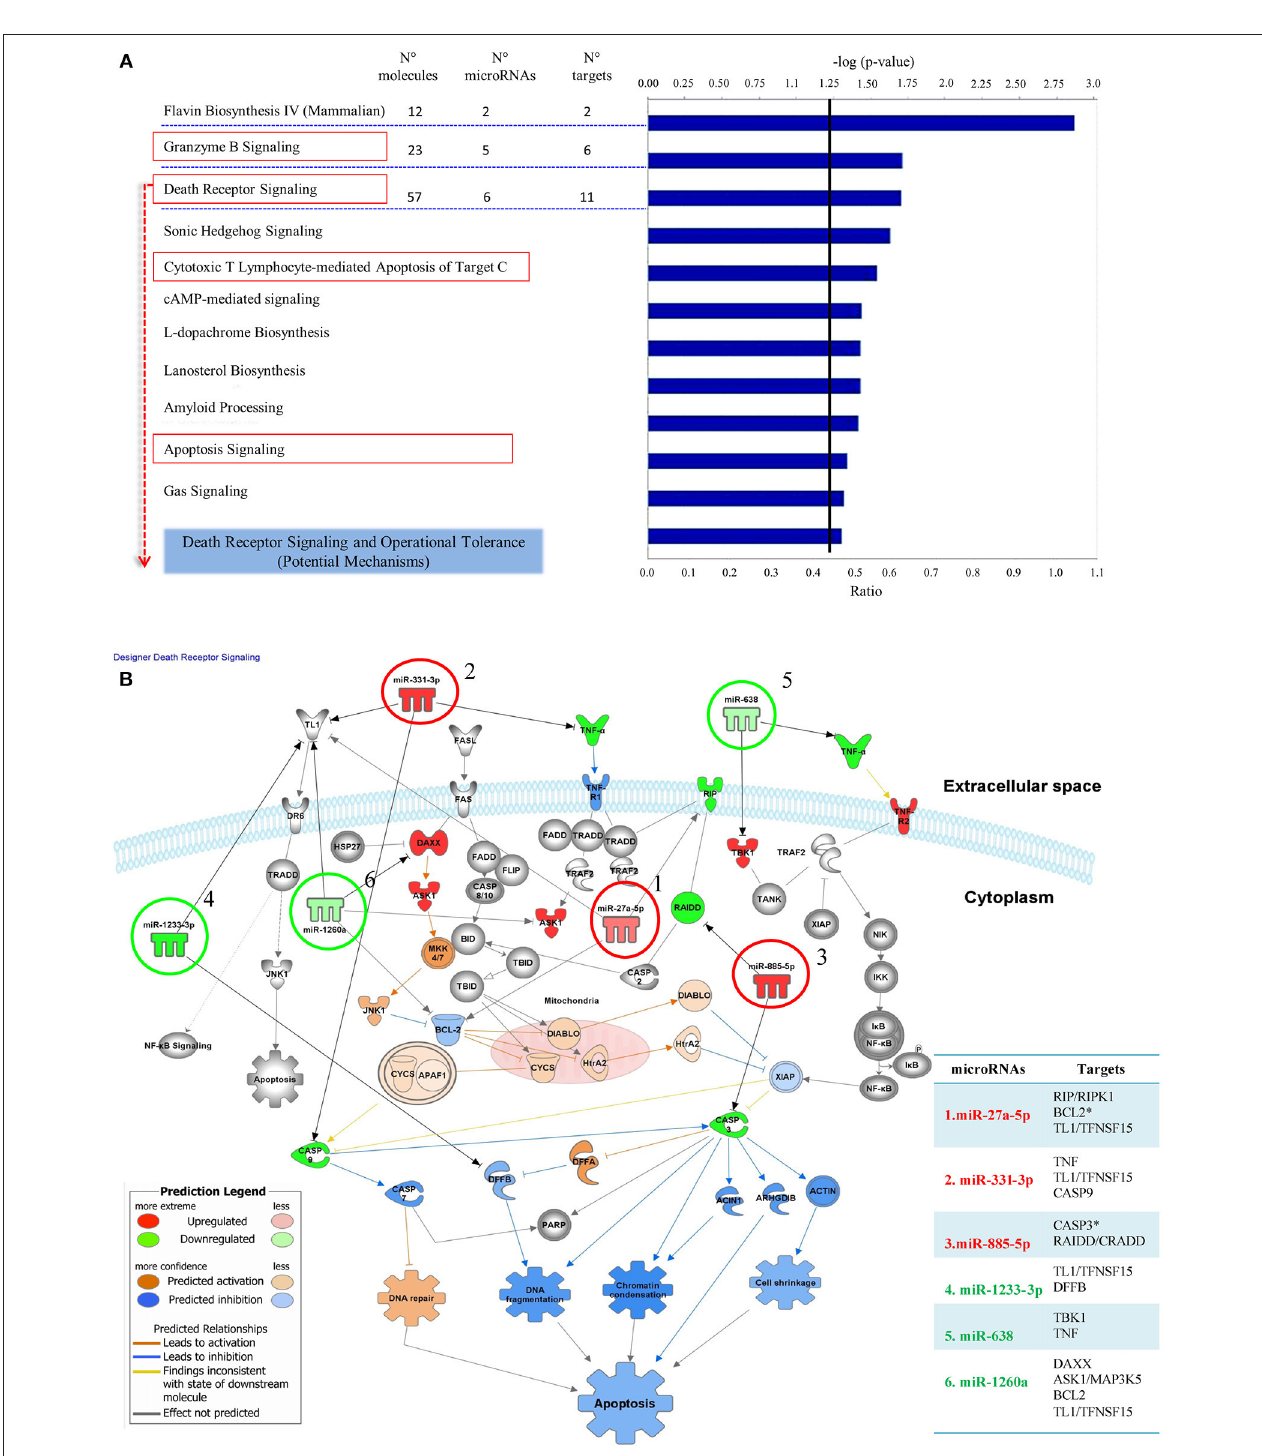
FIGURE 2 | Signaling pathways comprising target molecules of microRNAs of the OT-CR differential profile. (A) The first 11 canonical pathways derived from the IPA (Ingenuity Pathway analysis), involving microRNAs of the OT-CR differential profile . Following the “Core Analysis” of the IPA analysis, these 11 canonical pathways arose. The chart shows category rankings. At the top of the graph we show the levels of significance (–log ( p -value), Fisher’s exact test, defined here at 1.25). The “Ratio” value represents the number of microRNA targets in the pathway divided by the total number of pathway molecules. N ◦ molecules: total number of genes in the pathway; N ◦ microRNAs: total number of the microRNAs of the OT-CR differential profile in the pathway; N ◦ targets: total number of targets of the microRNAs comprised in the OT-CR differential profile, in the pathway. Boxes in red highlight the cell death pathways. (B) Graphical representation of the Death Receptor Pathway